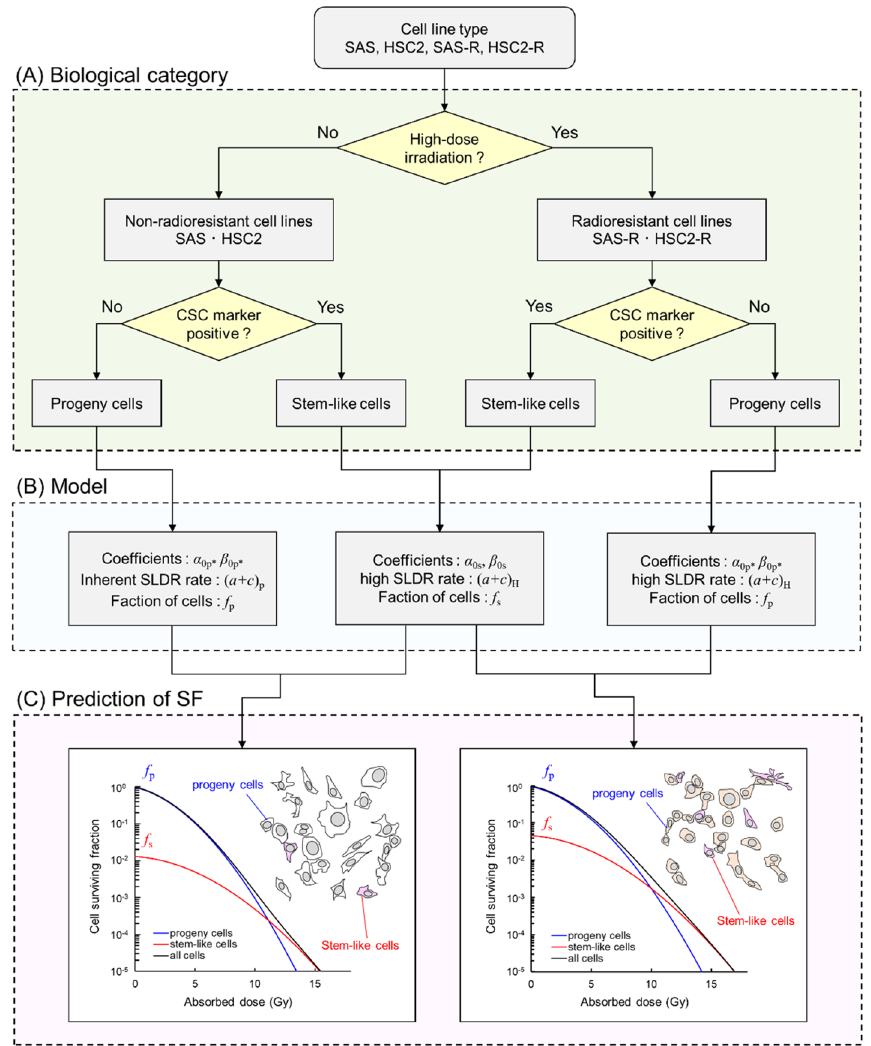
Figure 1. Categories of cancer cell lines and the overview of the IMK model. (A) the biological categories for SAS, SAS-R, HSC2 and HSC2-R, (B) the parameters in the IMK model and their characteristics, and (C) surviving fraction of cancer cells estimated based on the IMK model. Note that f p + f s = 1. We assumed the increased fraction of CSCs and the high DNA repair (SLDR) capability acquired in the progeny cells after fractionated irradiation with total high dose as the characteristics of radioresistant cell